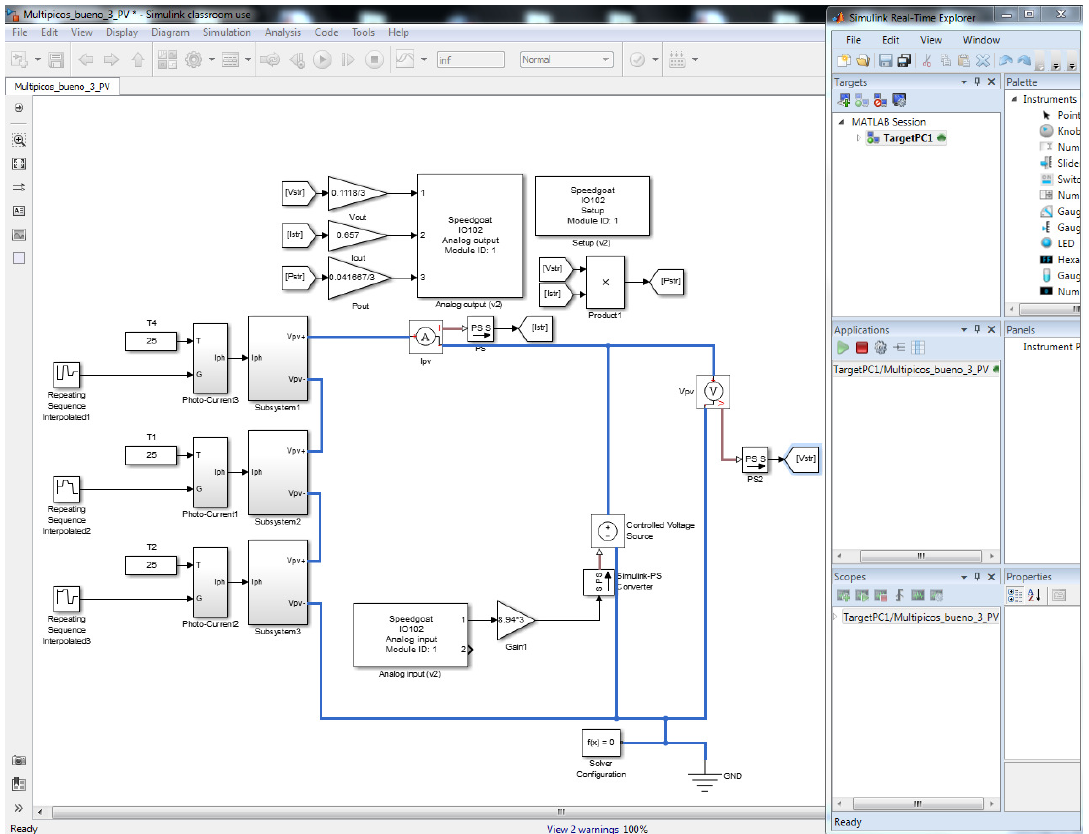
Figure 13. Model of three panels in series with irradiation blocks and control system in the